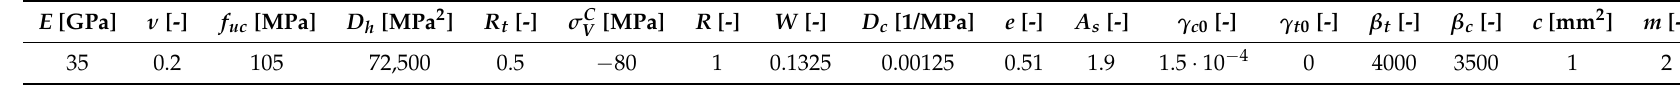
Table 2. Identified material parameters of concrete material